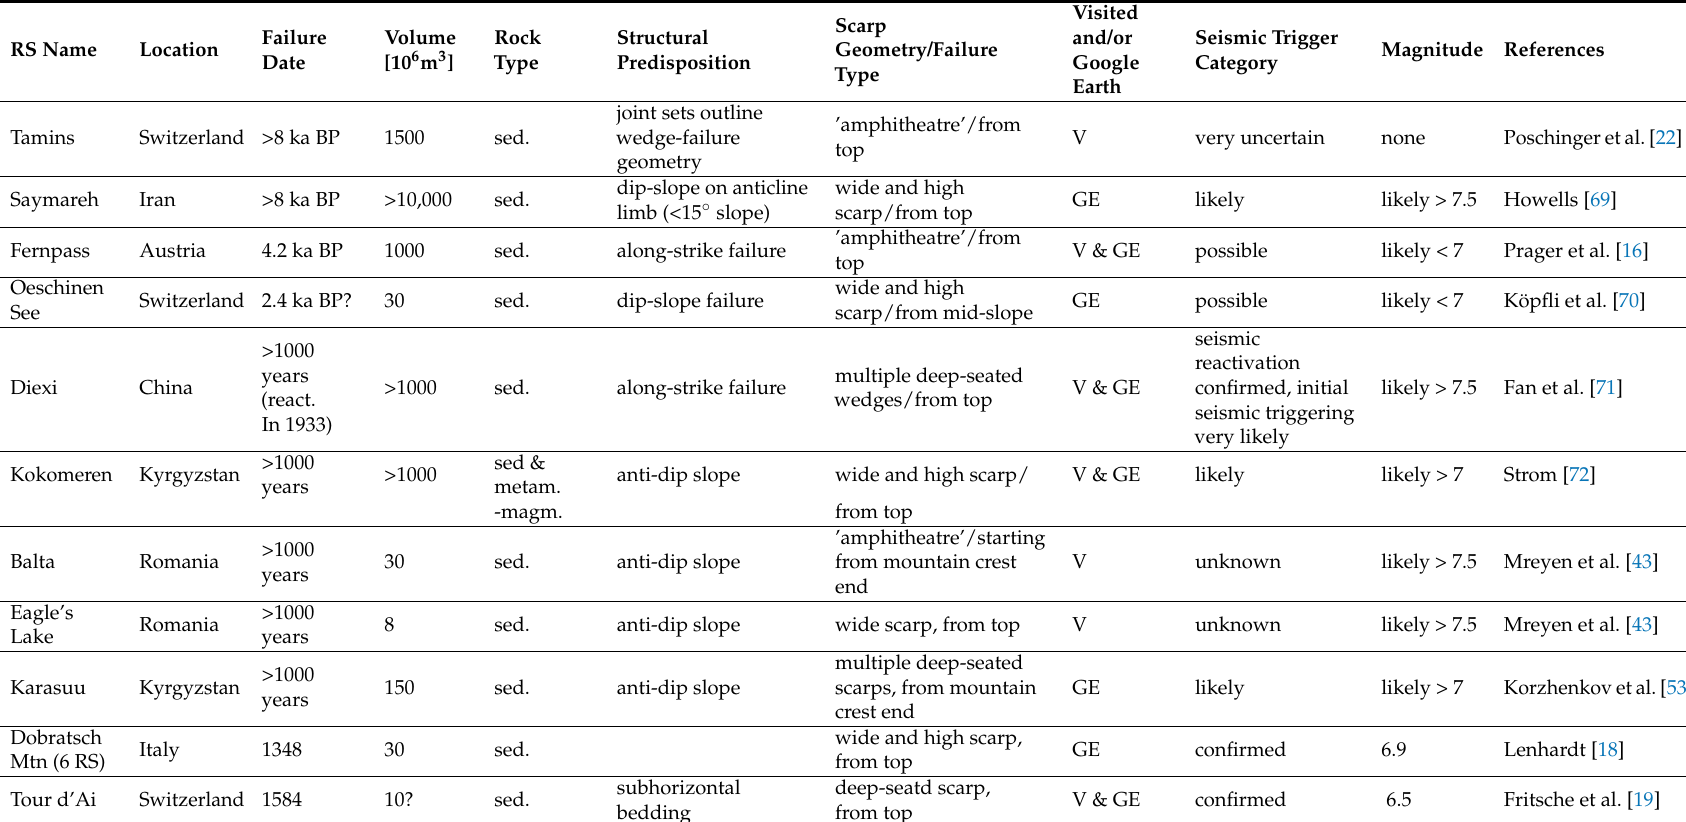
Table A1. Table case studies seismic triggered